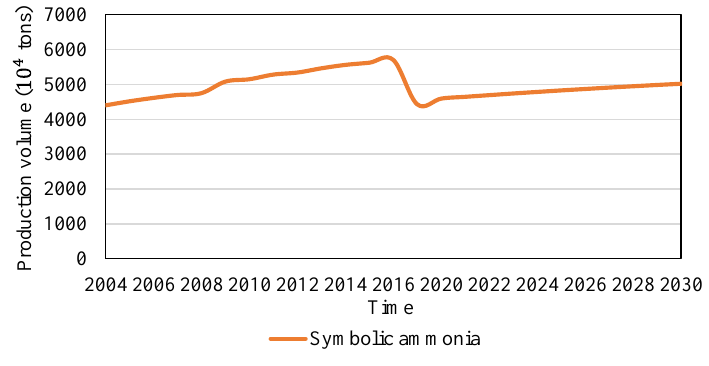
Figure 15. Synthetic ammonia production volume simulated until the year